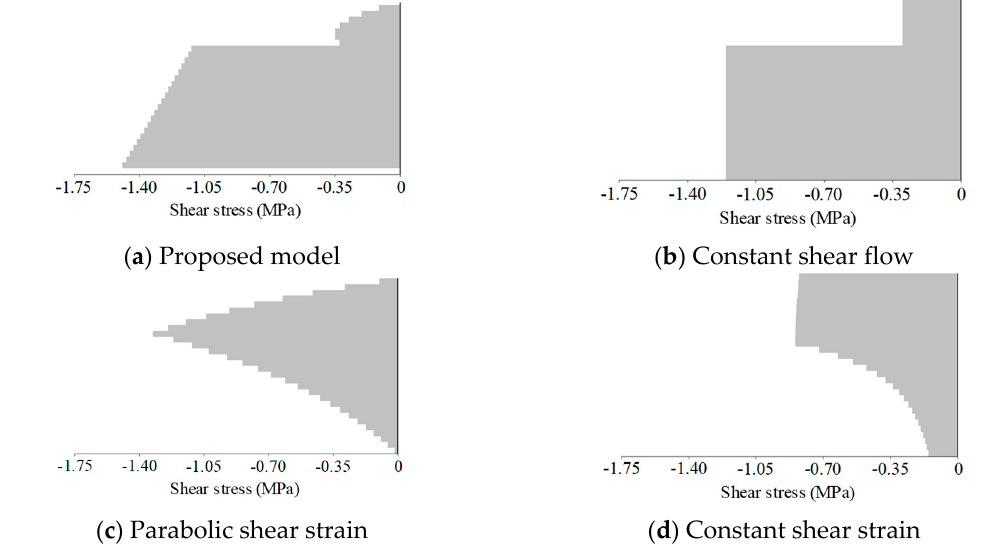
= ). Figure 14. Shear stress distribution over cross section (at critical section, V = 54.7